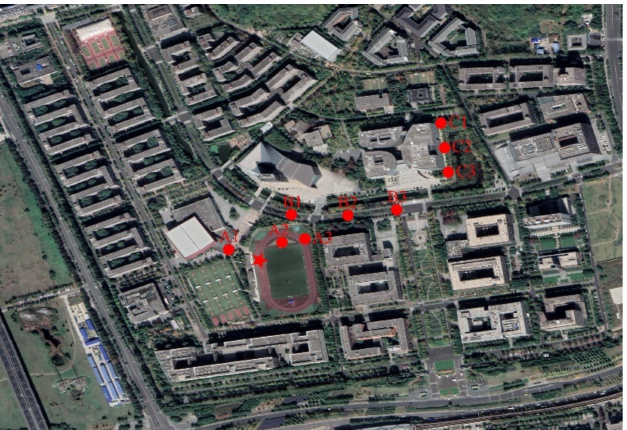
Figure 5. Location of release and sampling points in the experiment (pentagram is the release point; dots are sampling